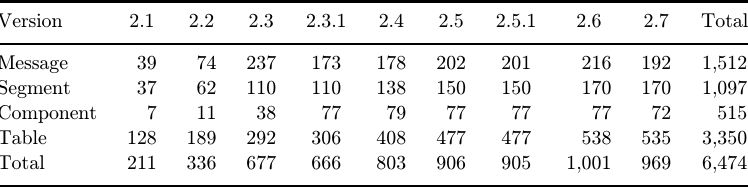
Table 1. Class amounts to compose the proposed HL7